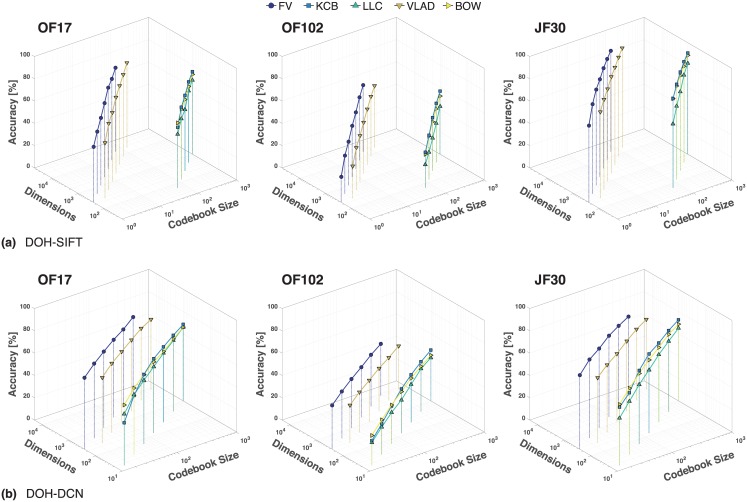
Classification accuracies using (a) DoH-SIFT and (b) DoH-DCD features and different encoding methods for discrete codebook sizes and image representation lengths.